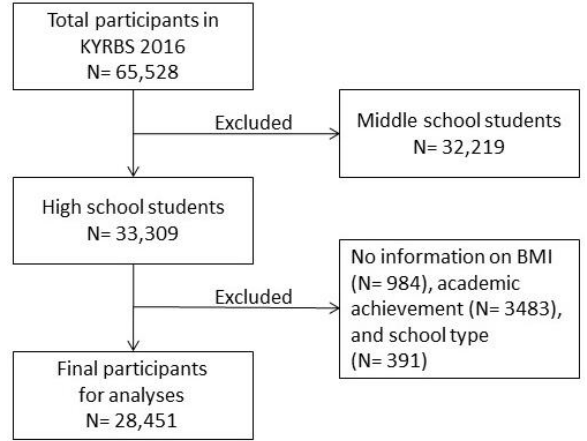
Figure 1. Flow chart of participant selection. KYRBS = the Twelfth Korea Youth Risk Behaviour Web-Based Survey 2016, BMI = body mass index.